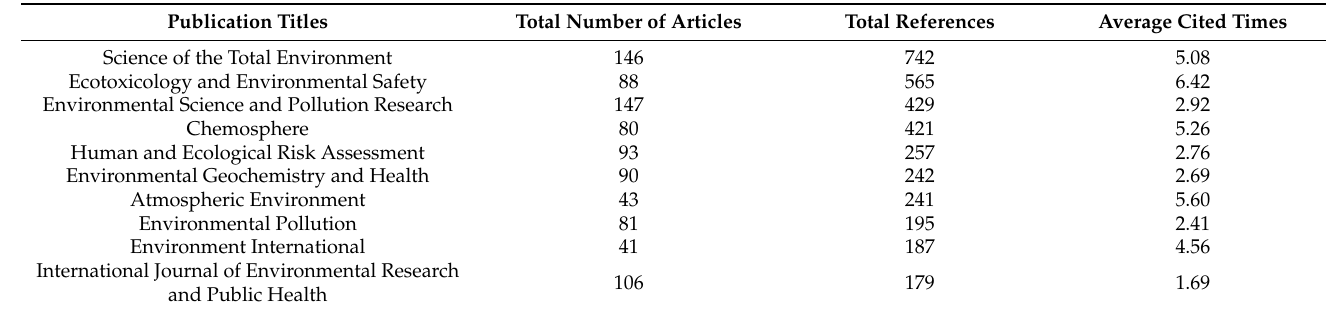
Table 3. Top 10 publication titles with influence.